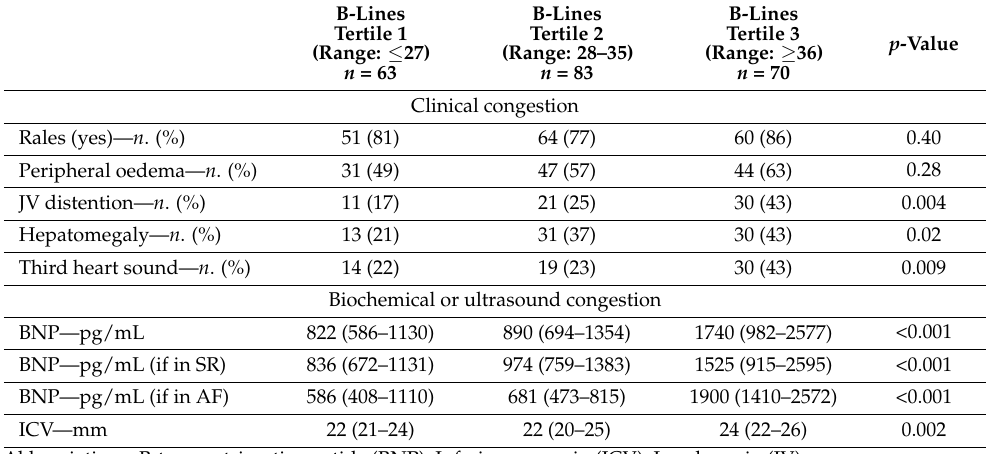
Table 2. Clinical, biochemical and ultrasound prevalence of congestion according to tertiles of B-lines.